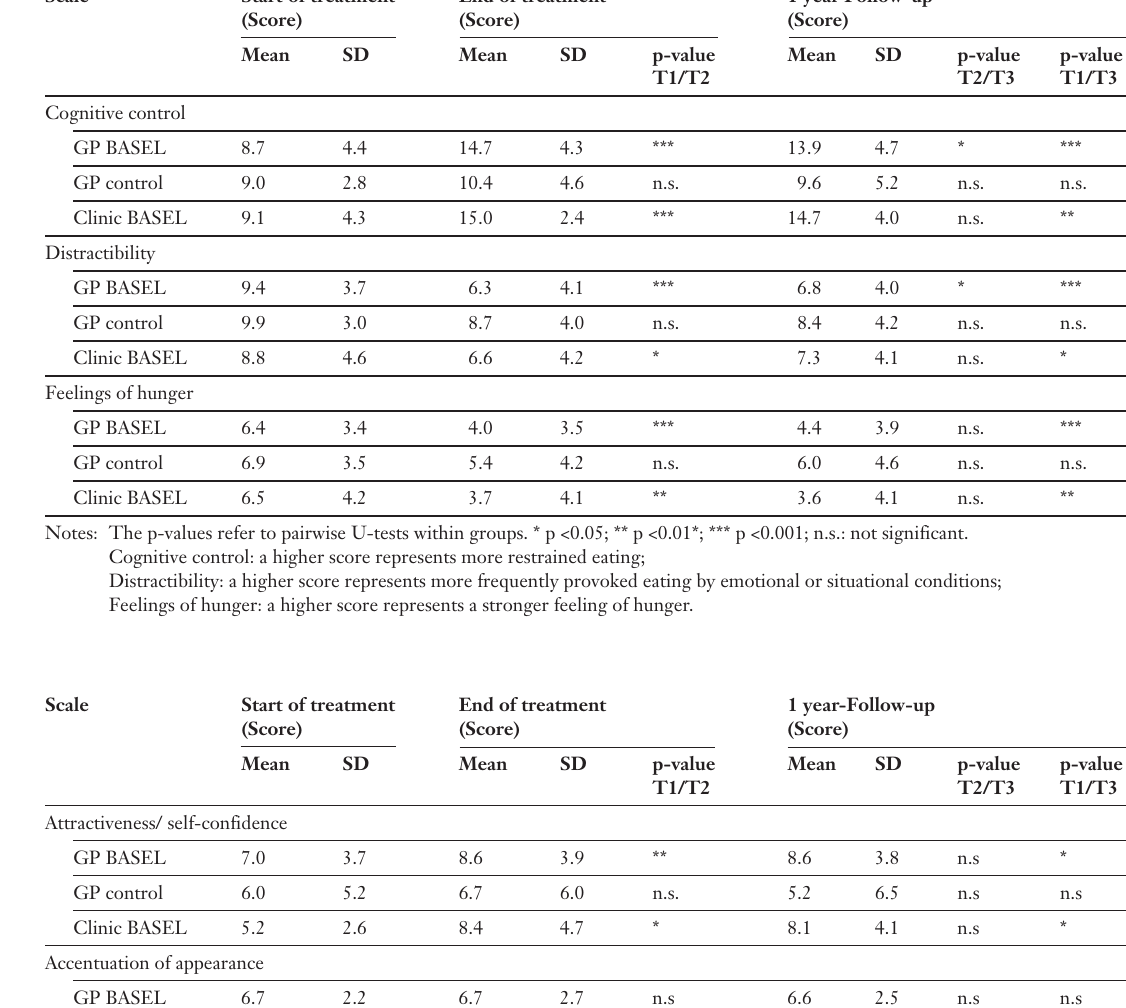
Table 5 Questionnaires of eating behaviour (FEV; QEB).